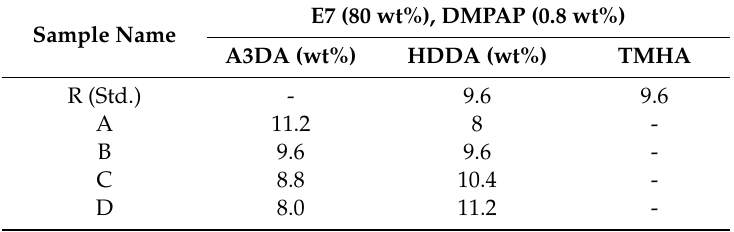
Figure 2. Transmittance dependence on the applied electric field for A3DA‐PDLC (sample B) and reference cell (sample R) measured at 303 K, λ = 633 nm.